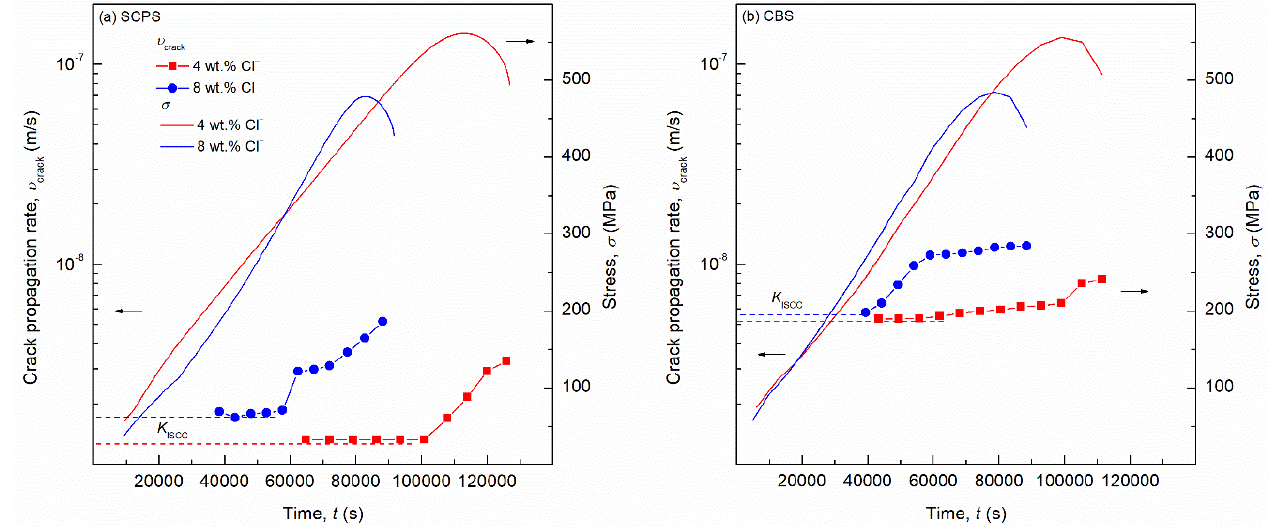
Figure 8. Crack propagation rate and stress monitoring UNS S32205 reinforcement during SSRT: ( a )